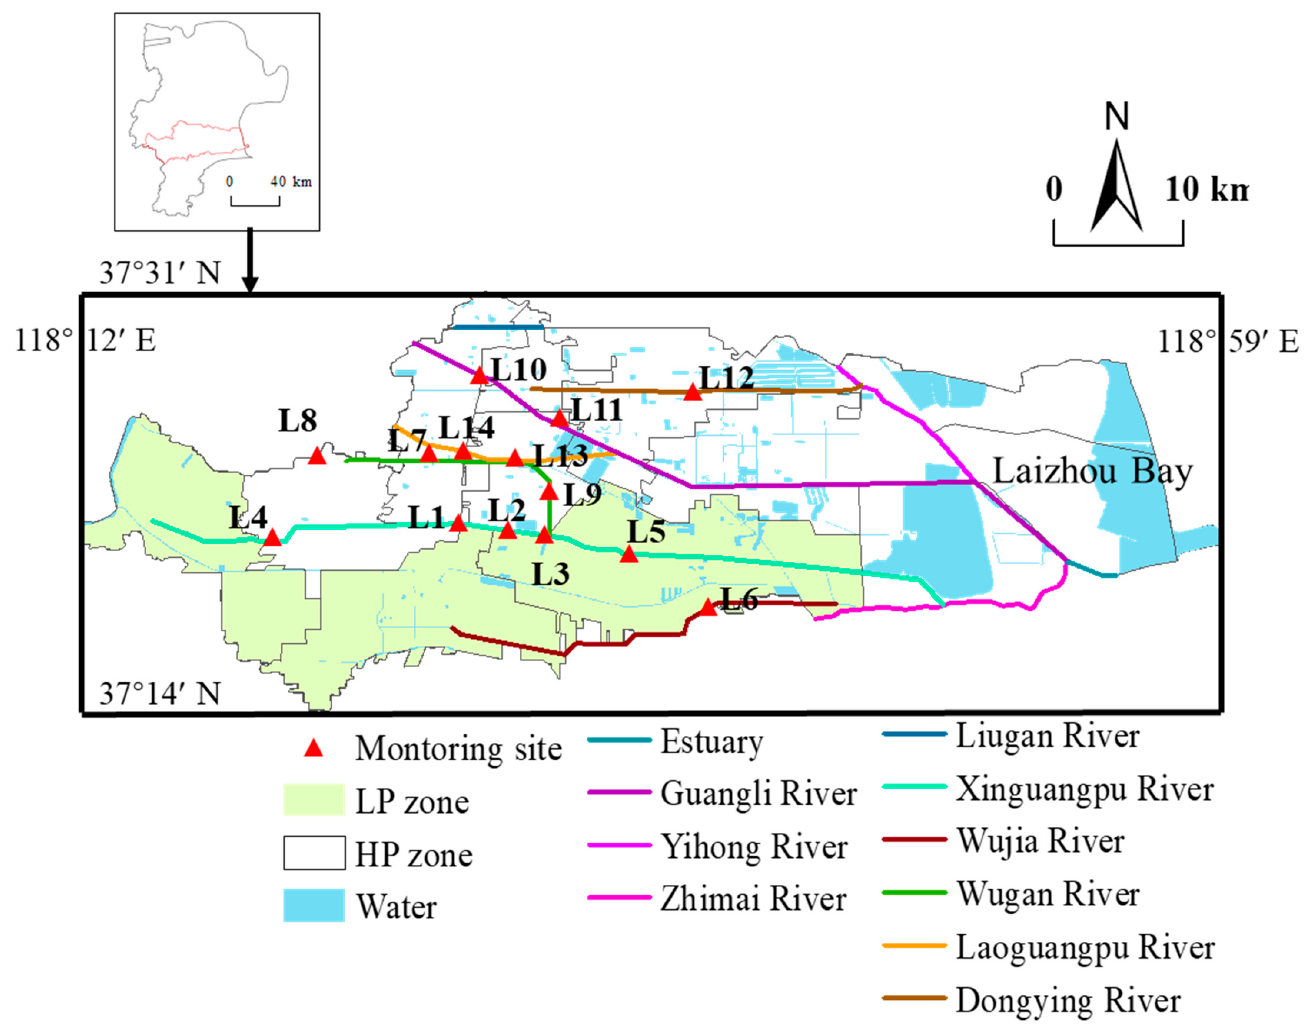
Figure 1. Map of the rivers and monitoring sites for water quality variables in Dongying District.